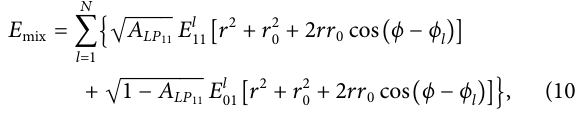
Frontiers in Physics |